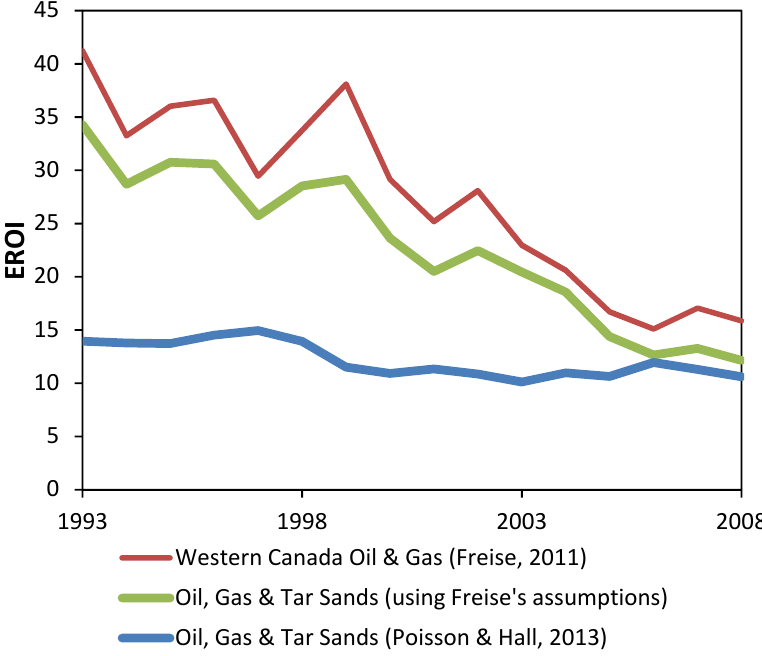
Figure 7. Comparison of our results for EROI for Canadian Oil and Gas with the results of a previous study